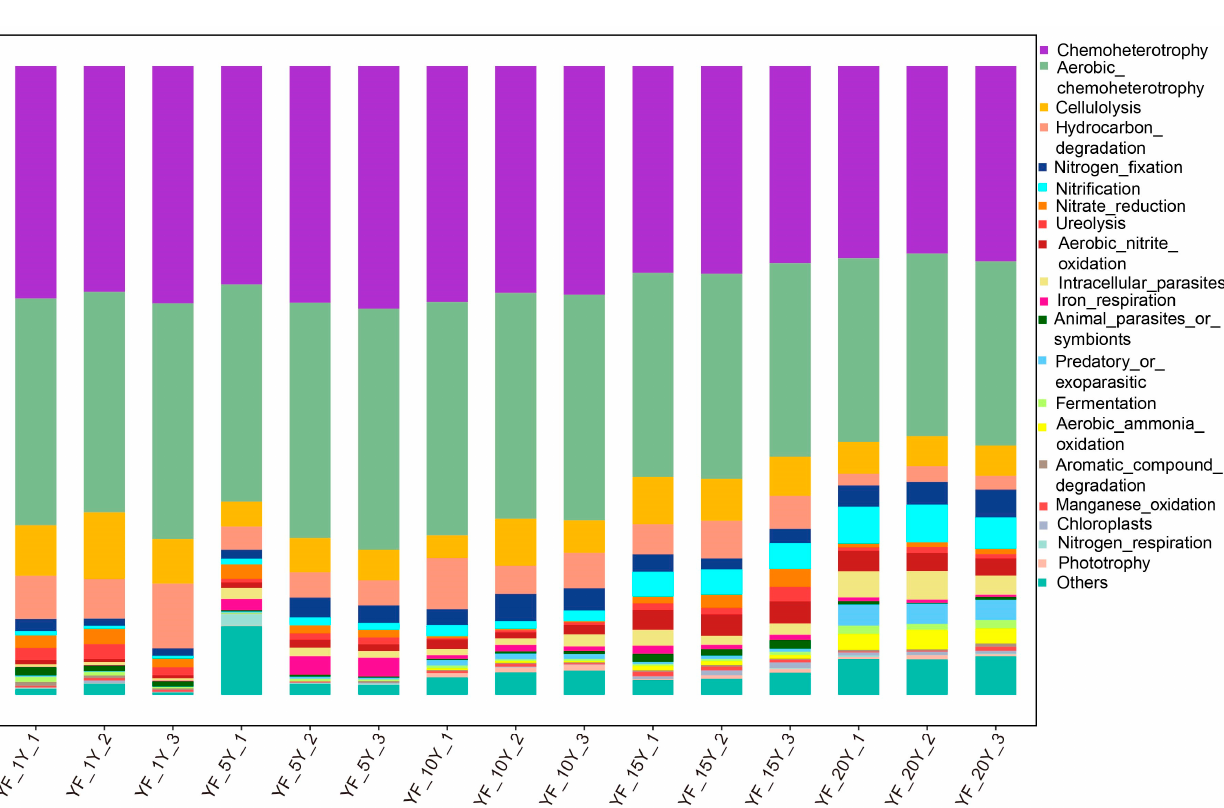
Figure 7. Stacked bar chart of dominant function group.